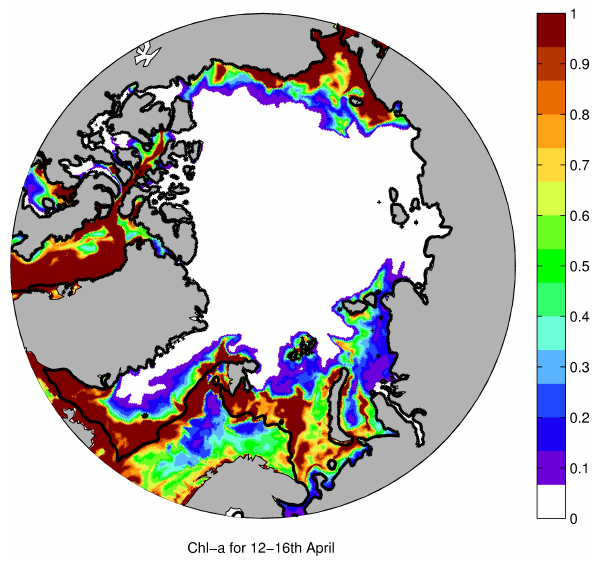
Fig. 8. Spatial distribution of the 5 day average surface concentra- tion of Chl- a (mgChlm − 3 ) for 13–16 April. Ice concentration of 50% is shown as a black